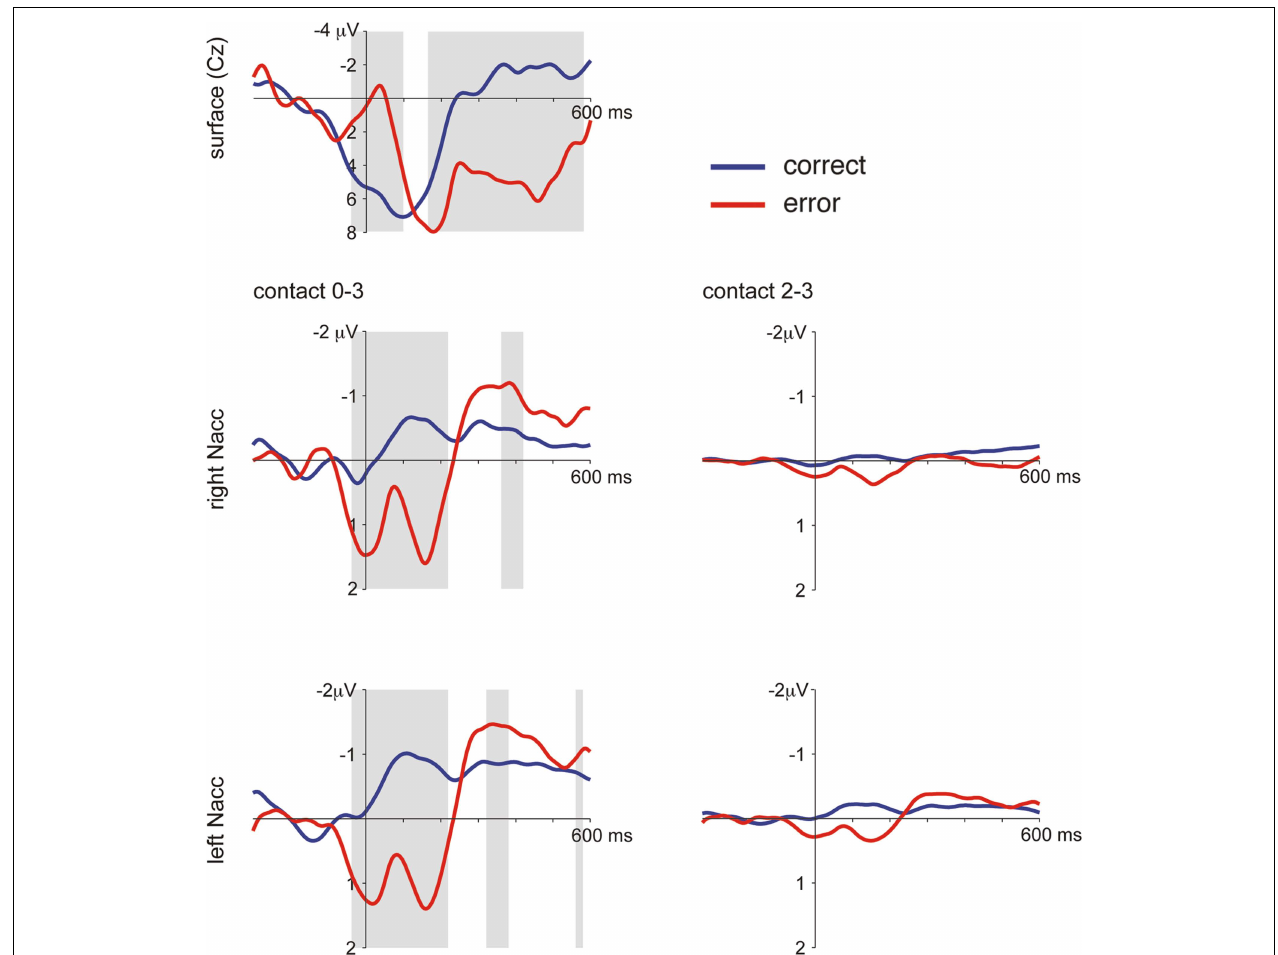
FIGURE 1 | Averaged LFP and surface ERP responses from Patient GM in the fl anker task. Averaged surface event-related potentials (electrode Cz referenced against mastoid process) and bipolar averaged LFPs obtained time-locked to the erroneous motor response. A typical error-related negativity followed by the so-called error positivity was seen in the ERP (signifi cant